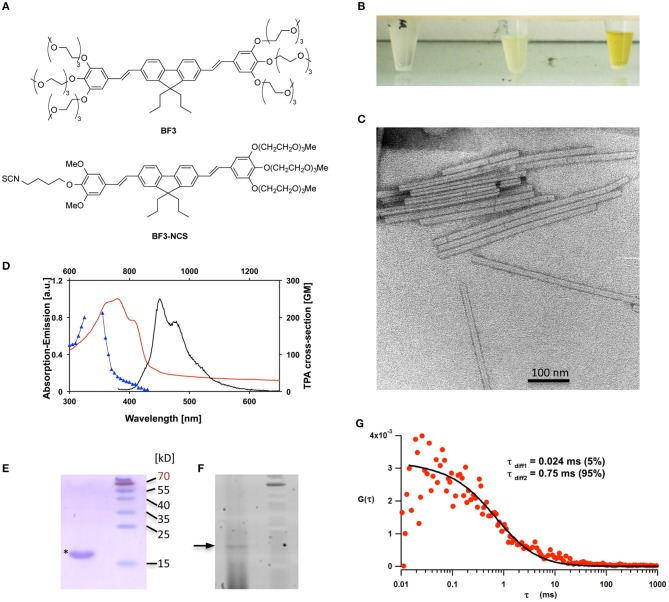
Production and analysis of TMV-BF3 particles. (A) Molecular formulae of BF3 and BF3-NCS. (B) Solutions containing purified TMV-particles before coupling (left), non-purified TMV particles after coupling (middle), and TMV particles size-purified after coupling (right). (C) EM image showing integrity of TMV particles after coupling. (D) Absorption (red) and emission (black) spectra of TMV-BF3 particles in phosphate buffer; two-photon excitation spectrum (blue) of BF3-NCS in water; a.u., arbitrary units; GM, Goeppert-Mayer units. (E,F) Electrophoretic analysis of the size-purified TMV-BF3 particles under denaturing conditions. (E) Coomassie blue-stained SDS-PAGE gel showing the presence of CP (17.6 kD, asterisk). (F) Same gel as in E but analyzed with a fluorescence scanner equipped with a sypro2 filter. A fluorescent band at approximately 18.5 kD is detected and confirms the presence of BF3-coupled CP. The orange dye conjugated to the 70 kDa protein of the size ladder (Thermo Scientific) also exhibits fluorescence under the illumination conditions used. The occurrence of fluorescence below the BF3-CP band suggests that the bond between BF3 and CP is partially sensitive to the denaturating SDS-PAGE conditions. (G) TP-FCS analysis of TMV-BF3 particles under native conditions showing a long diffusion time of 0.75 ms corresponding to the labeled viral particle (>95%) and a shorter time of 0.024 ms corresponding to free dye (<5%).